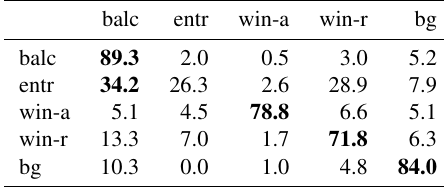
Table 6: Confusion matrix using aggregates of A 2 , A 3 and A 4 , accuracy 78 . 4 , see Table 1